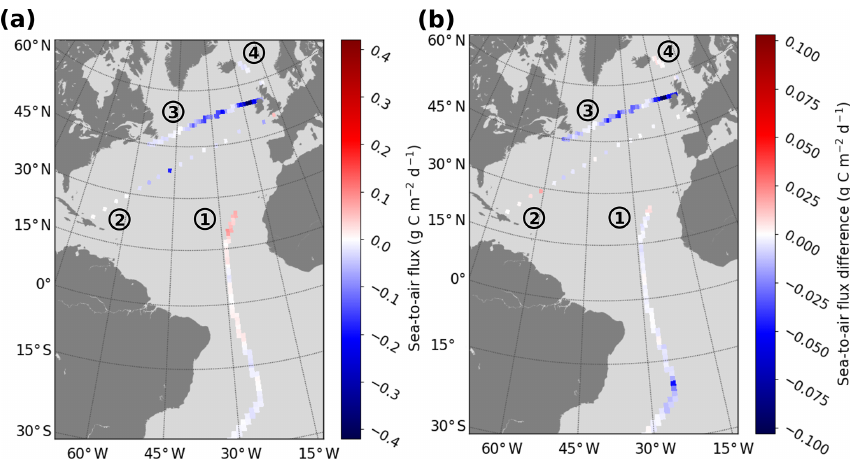
Figure 3. Example sea-to-air CO 2 fluxes calculated using in situ data and the gas transfer velocity detailed in Ho et al. (2006) (a) fluxes calculated for four sampling cruises in the North Atlantic during October and November 2013 (Kitidis and Brown, 2017; Schuster, 2016; Steinhoff et al., 2016; Wanninkhof and Pierrot, 2016; labelled 1–4, respectively). (b) The difference in the calculated flux resulting from using the reanalysed f CO 2 compared to the original in situ f CO 2 data (reanalysed minus